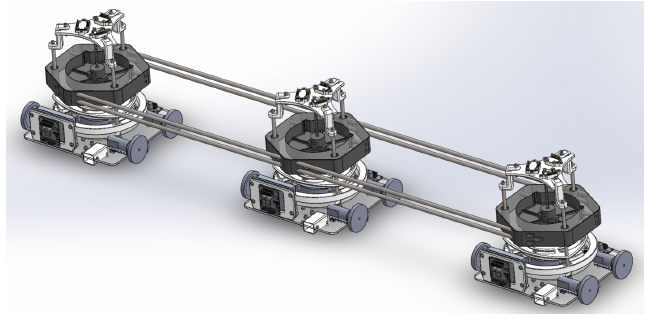
Figure 2. Modular design of the Mantis V2